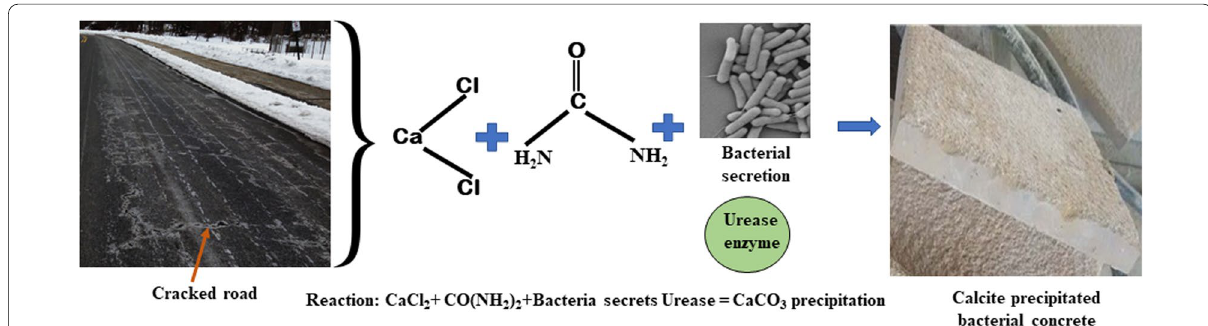
Fig. 4 Halophilic bacteria used in road crack